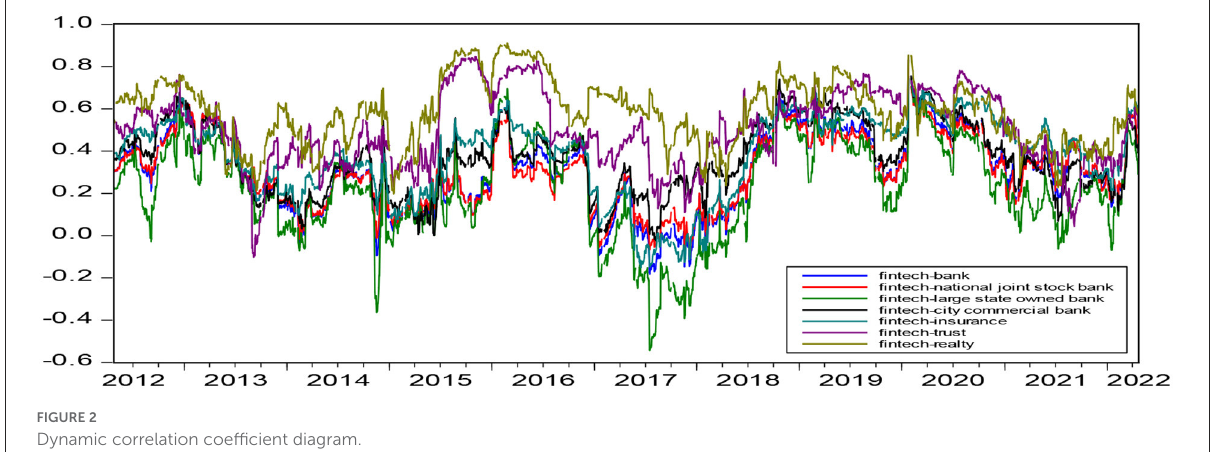
FIGURE2 Dynamic correlation coefficient